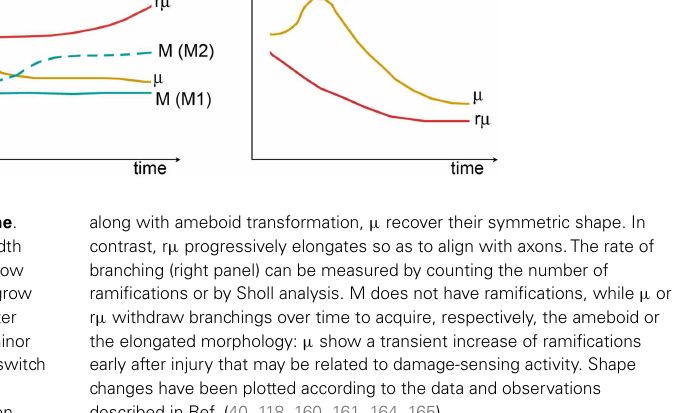
FIGURE 4 | Shape changes of different myeloid cell types over time . Cell size (left panel) can be measured by assessing cell area or cell width (caliper).While in monocytes (M), the size is constant, microglia ( µ ) grow larger (hypertrophic reactive morphology), and rod microglia (r µ ) first grow and then shrink (elongated not ramified morphology). Elongation (center panel) can be evaluated from the ratio between the cell’s major and minor axes. A certain degree of elongation is selectively associated with M switch to M2 polarization. Elongation of µ might occur during early damage-sensing as µ direct ramifications toward the site of injury.Then,